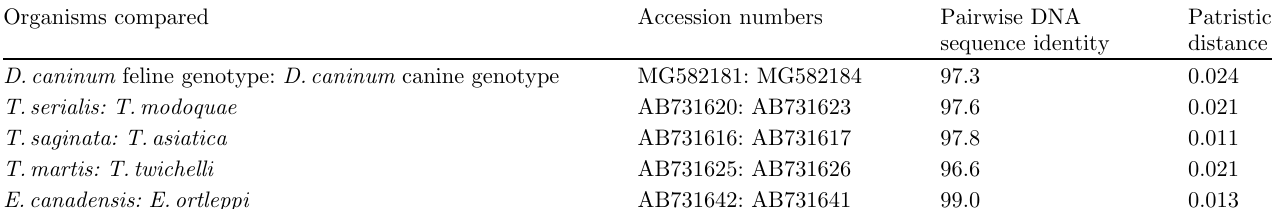
Table 6. 18S rDNA sequence identity and patristic distance observed between the D. caninum feline and canine genotypes and different